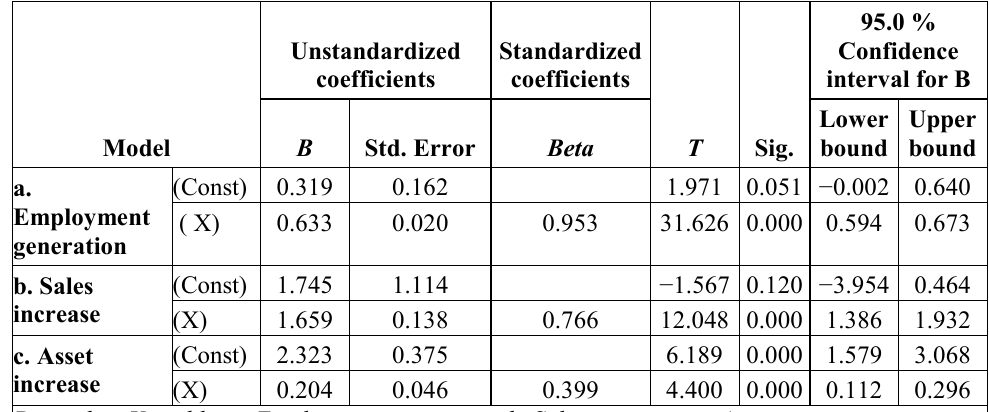
Table 7. The Coefficients of the Relationship between Dependent and Independent Variables (made by the